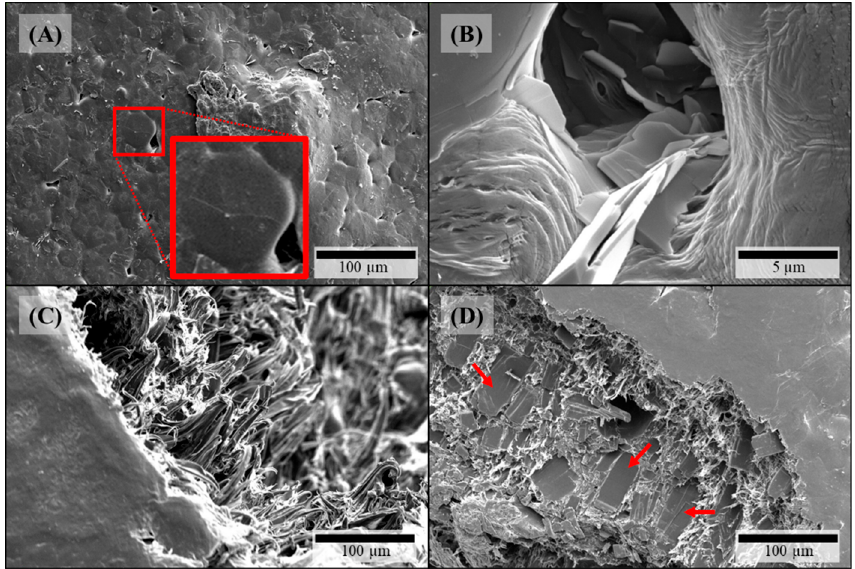
Figure 4. SEM pictures of PEO-based filaments: ( A ) PEO15-P surface, insert: magnification of octagonal structure; ( B ) PEO15-P surface close-up; ( C ) PEO15 fracture face; ( D ) PEO35 fracture face.